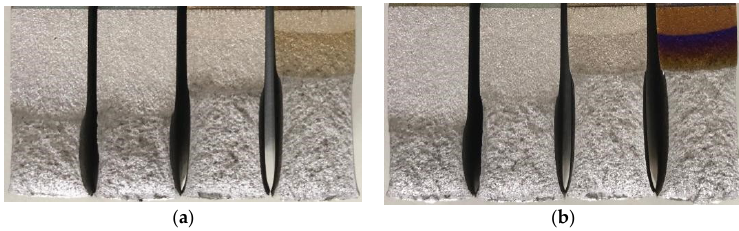
Figure 10. Macroscopic fracture surface under high load ratio: ( a ) pure fatigue; ( b ) dwell fatigue (the temperature increases from left to right).